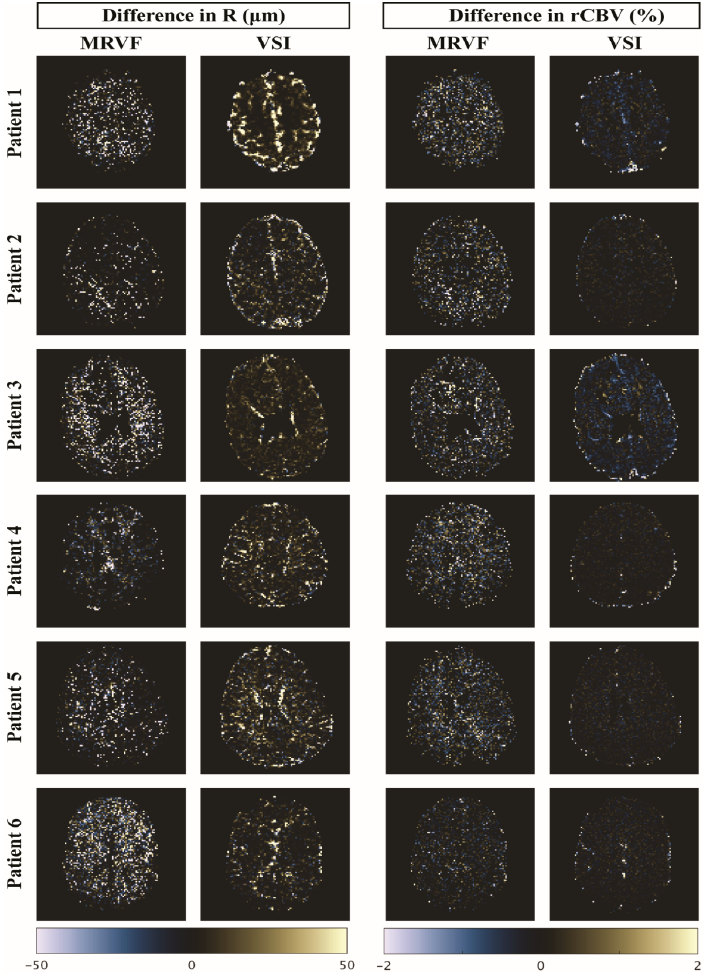
Figure 7. Difference maps of R (in μ m) and rCBV (in %) estimated from raw and noisy data using MRVF and VSI for the 6 patient datasets.